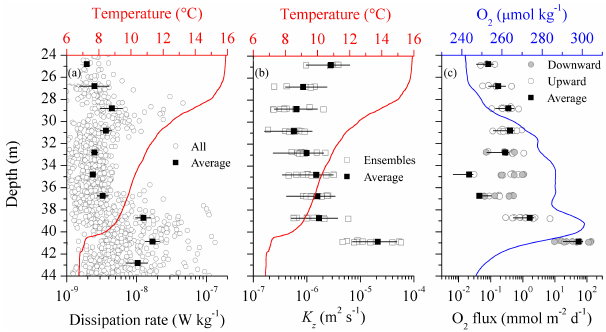
Figure 4. Overview of turbulent transport and O 2 fluxes within the interior layer (defined in Fig. 2). Each panel is overlaid with temperature (a, b) and O 2 concentration (c) profiles. (a) Dissipa- tion from all profiles (open dots) together with the arithmetic mean (solid squares). (b) Average vertical eddy diffusion coefficient K z with uncertainties bars and the K z values for every ensemble (open squares), which represent the average over 3–4 consecutive profiles. (c) Calculated average O 2 flux over 2m bins with the respective un- certainties intervals (solid square and black line). The values for each profile cluster are shown both downward and upward fluxes (grey solid and open dots, respectively). Note that in the center in- terior layer (33–37m) the average reflects the combination of the variability of the observed upward and downwards